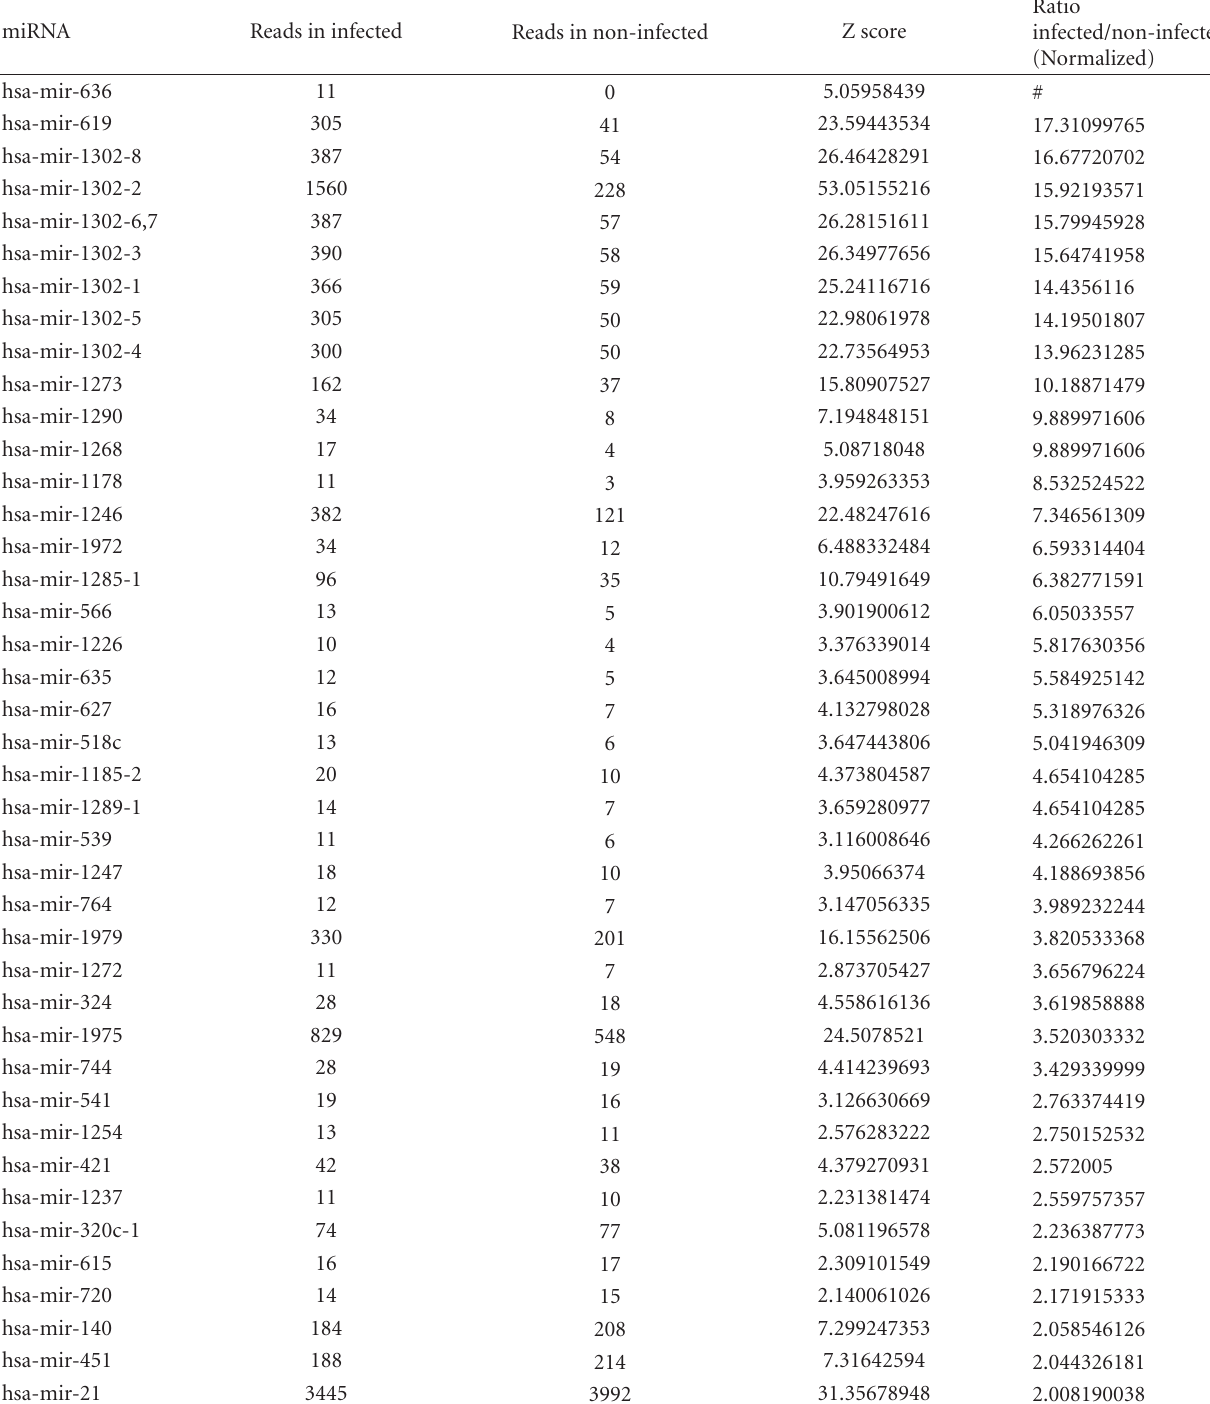
Table 2: Upexpressed miRNAs in infected cells compared with non-infected